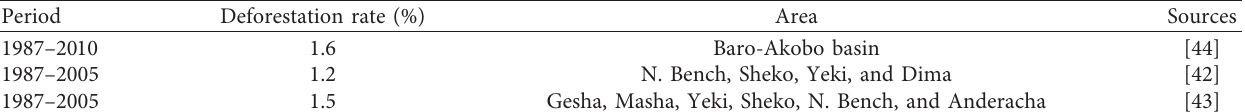
Table 4: Estimated rates of deforestation in the Southwestern Ethiopia.